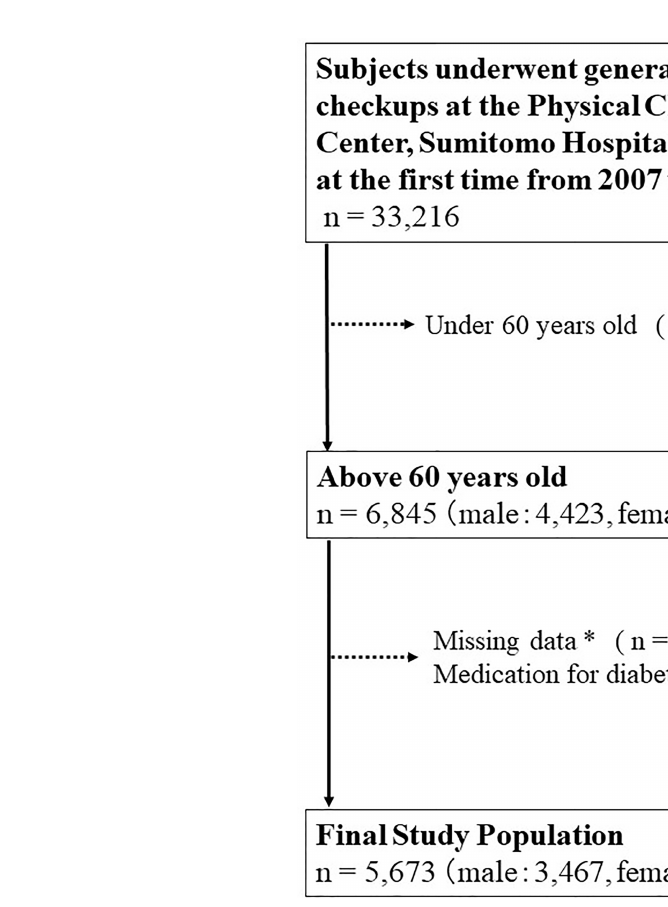
FIGURE 1 | Inclusion and exclusion processes of the present study. * Including age, sex, body mass index, waist circumference, systolic blood pressure, diastolic blood pressure, hemoglobin, aspartate transaminase, alanine aminotransferase, albumin, total cholesterol, triglyceride, high-density lipoprotein cholesterol, low- density lipoprotein cholesterol, fasting blood sugar level, creatinine, uric acid, estimated glomerular fi ltration rate (e-GFR), hemoglobin A1c, insulin, adiponectin, smoking habits, alcohol consumption per day, medical history of hypertension, diabetes mellitus, dyslipidemia, stroke, hyperuricemia or coronary artery